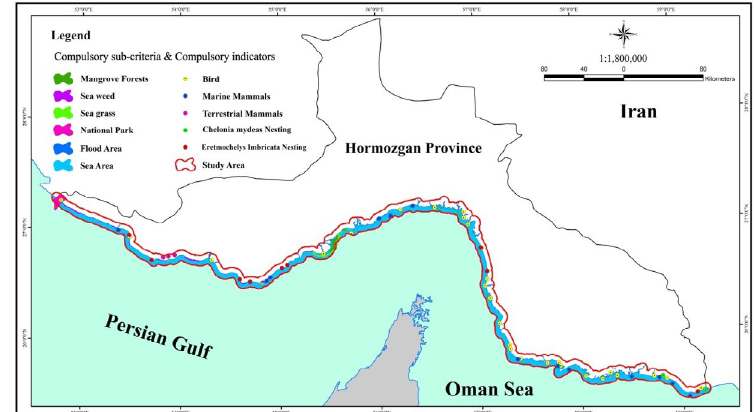
Fig. 6: Map of the compulsory sub-criteria and indicators in study area